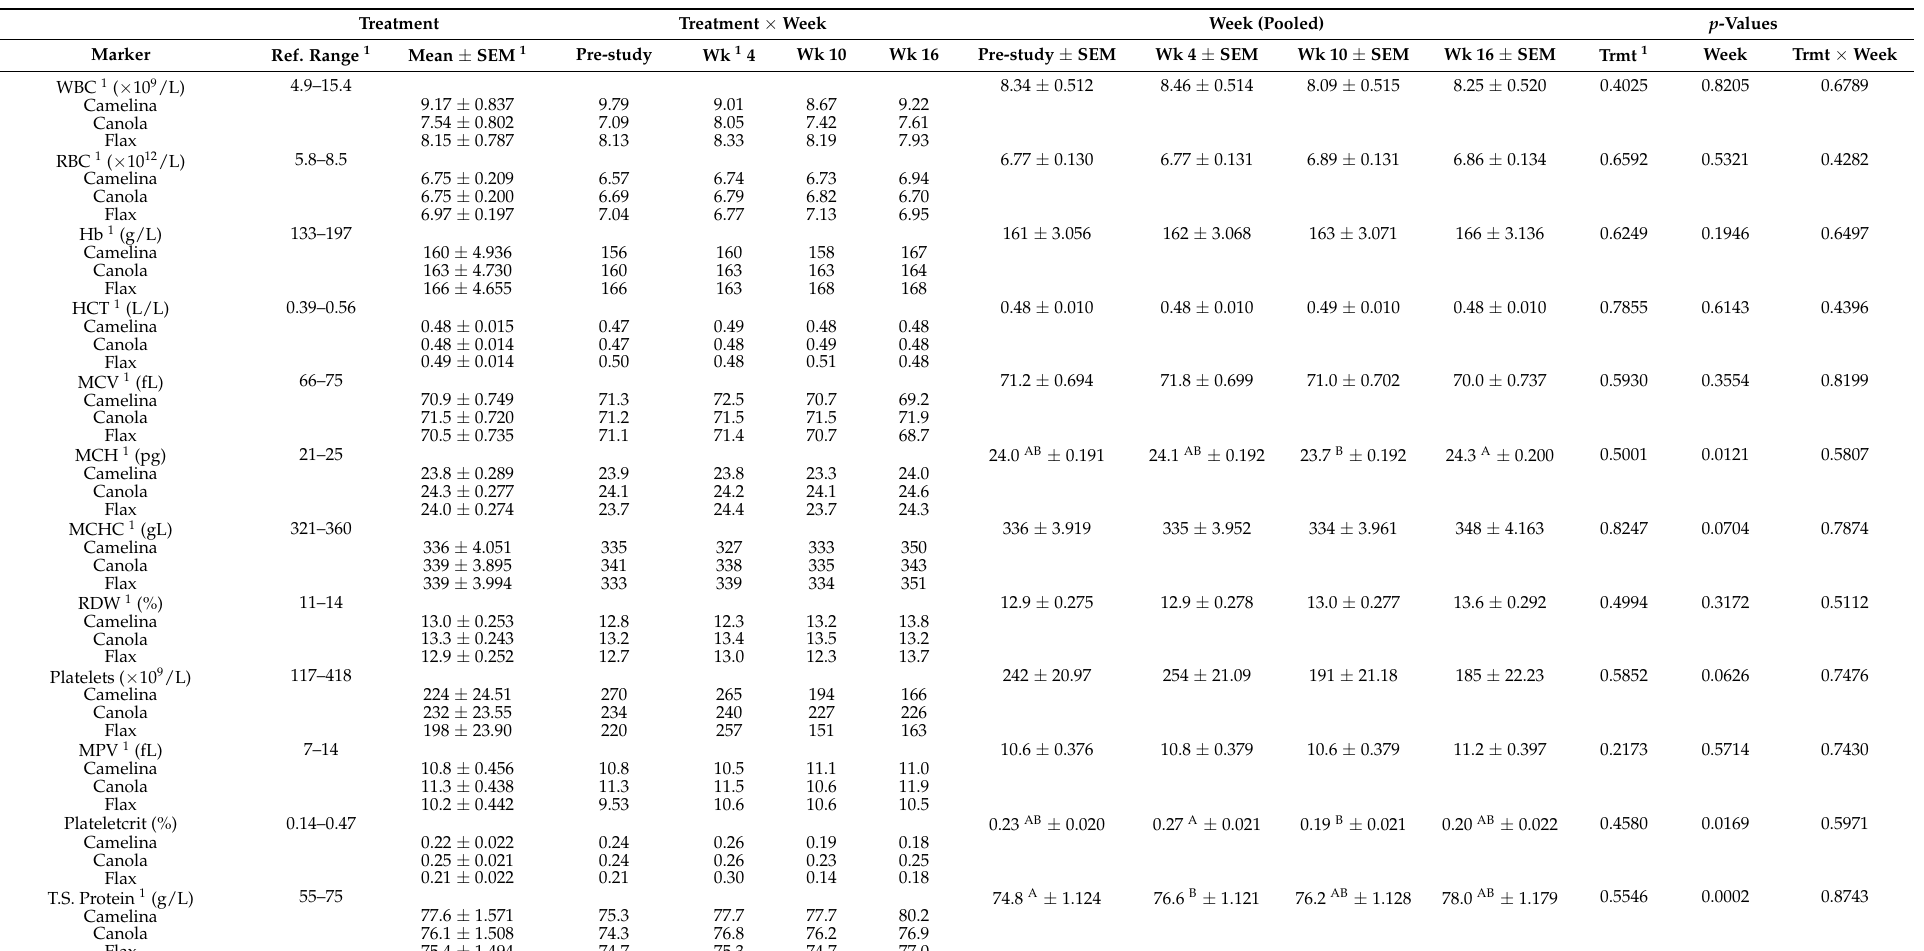
Table 4. Hematology of healthy, adult dogs fed one of three dietary oil supplements (camelina, flax, or canola oil) over a 16-week period. Values are shown are lsmeans estimates for treatment (oil), treatment by week interaction, and week. Treatment Treatment × Week Week (Pooled) p -Values